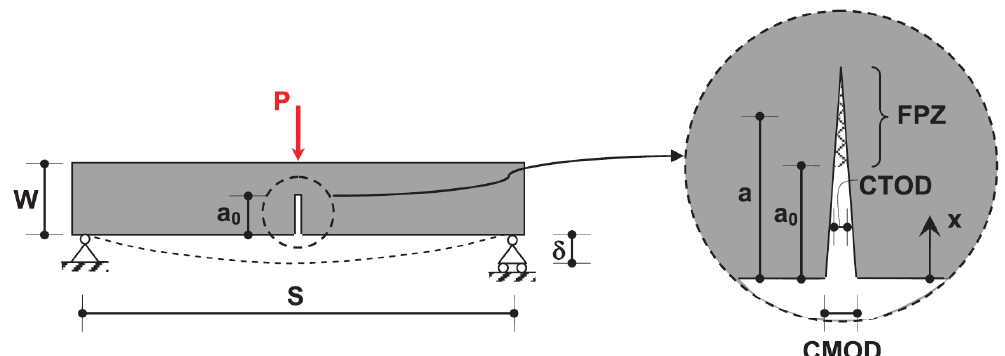
Figure 1: Geometrical and testing configuration of notched specimen under three-point bend